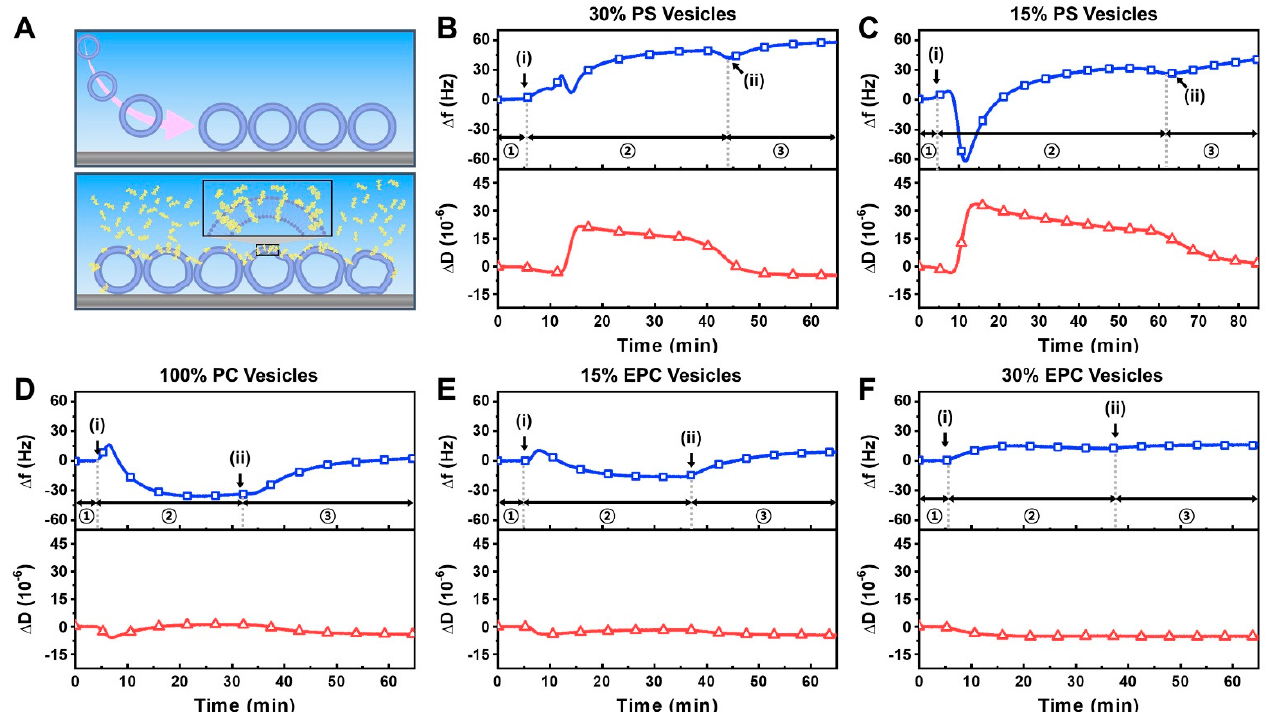
Figure 3. QCM-D tracking of LTX-315 peptide interactions with intact vesicle adlayer depending on membrane surface charge: ( A ) schematic illustration of intact vesicle adlayer on TiO 2 -coated sensor surface before and after peptide addition; ( B – F ) corresponding QCM-D measurement kinetics for peptide addition to ( B ) 70/30 DOPC/DOPS, ( C ) 85/15 DOPC/DOPS, ( D ) 100 DOPC, ( E ) 85/15 DOPC/DOEPC; and ( F ) 70/30 DOPC/DOEPC lipid vesicle adlayers. In each panel, the QCM-D Δ f (top, blue squares) and Δ D (bottom, red triangles) shifts are presented as a function of time and the initial baseline signals correspond to the intact vesicle adlayer. Stages 1, 2, and 3 correspond to intact vesicle platform alone, during peptide addition, and during buffer washing, respectively. Arrows i and ii denote peptide addition and buffer washing steps, respectively.